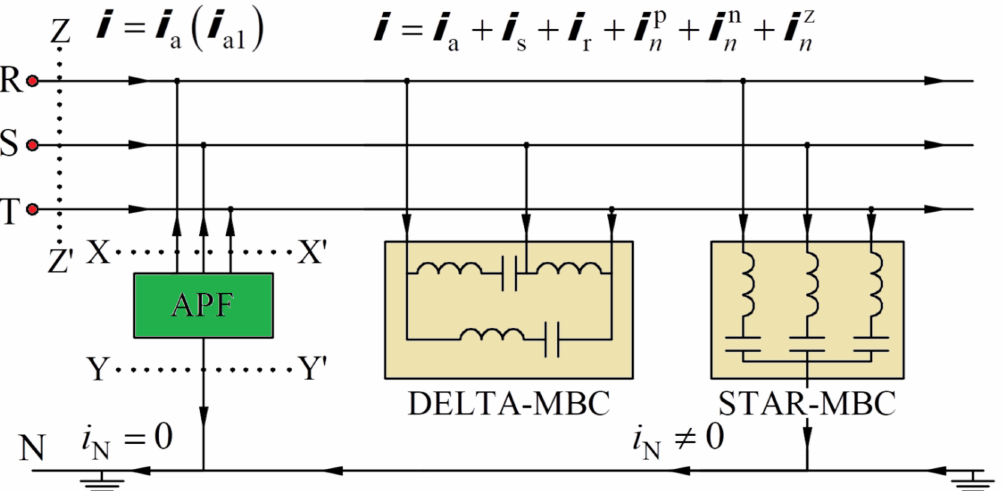
Figure 8. The analyzed theoretical illustration which connected the minimizing balancing compensators (MBC) and the active power filter (APF).